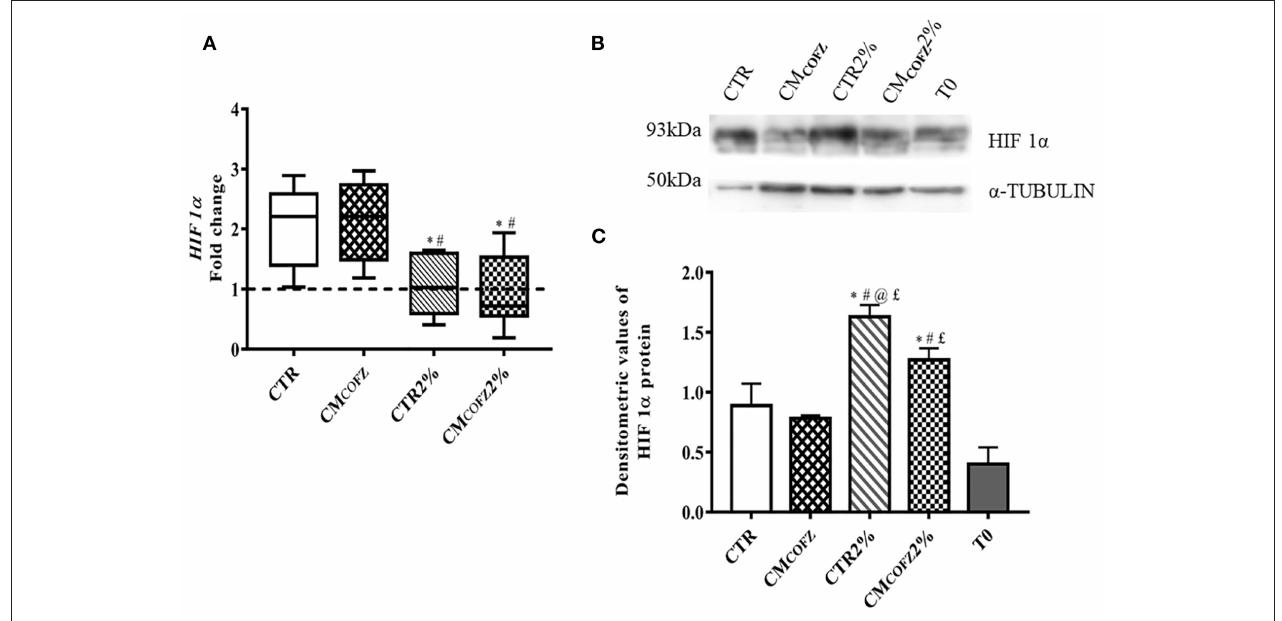
FIGURE 5 | Physoxia effects of tenogenic potential of CM COFZ on AECs after 14 days of culture. (A) Real time qPCR analysis for HIF 1 α expression in normoxia CTR and CM COFZ and in physoxia CTR 2% and CM COFZ 2% conditions. Relative quantification of each mRNA gene expression normalized to endogenous GAPDH (internal control) was calculated using the 11 Ct method and presented as fold change over the AECs T0 = 1 (calibrator; dashed line). (B) Representative Western Blot image for HIF 1 α and α -TUBULIN proteins expression on different experimental conditions. (C) HIF 1 α protein quantification normalized on α -TUBULIN expression levels and expressed as means ± S.D of three replicates/each experimental condition. Values were considered significant when p < 0.05, with the indicated superscripts *vs.